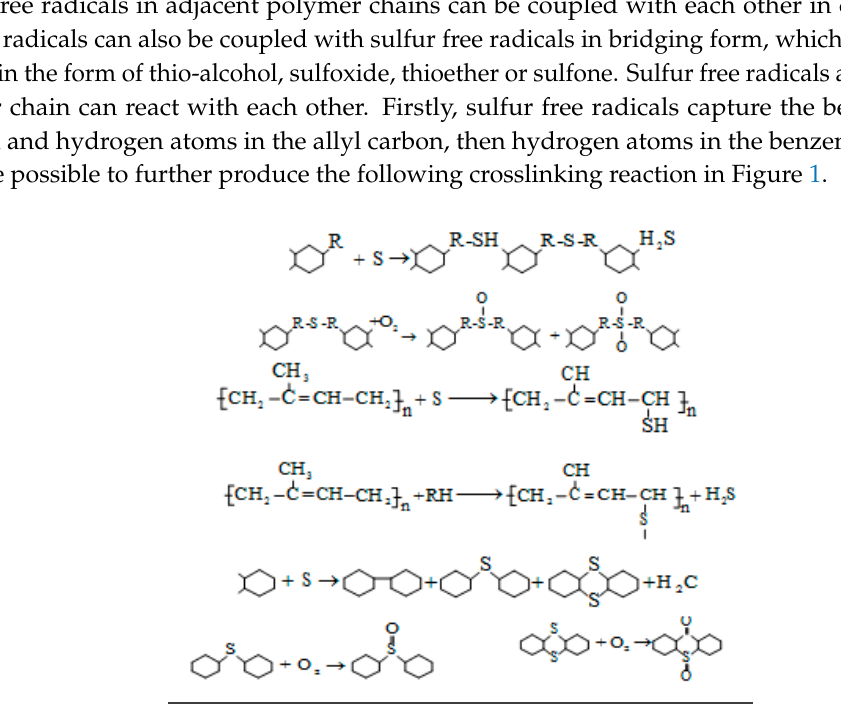
Figure 1. Vulcanization reaction mechanism [23].